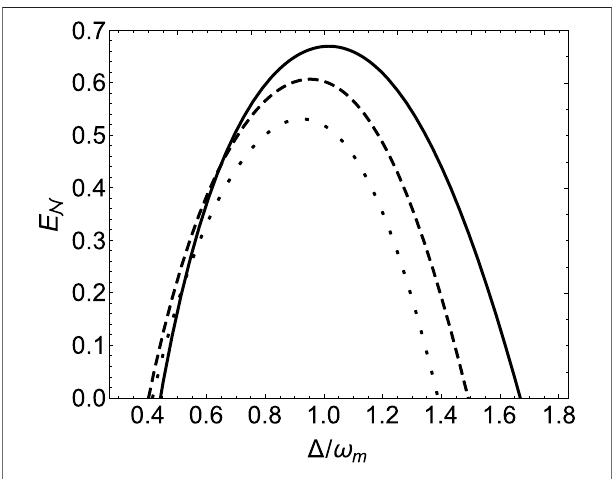
FIGURE 6 | Logarithmic negativity E N as a function of the normalization detuning Δ / ω m for different masses of oscillators. The solid line refers to m (cid:1) 5ng, and the dash line stands for m with 50 ng. The temperature of the system is T = 0.4 K.